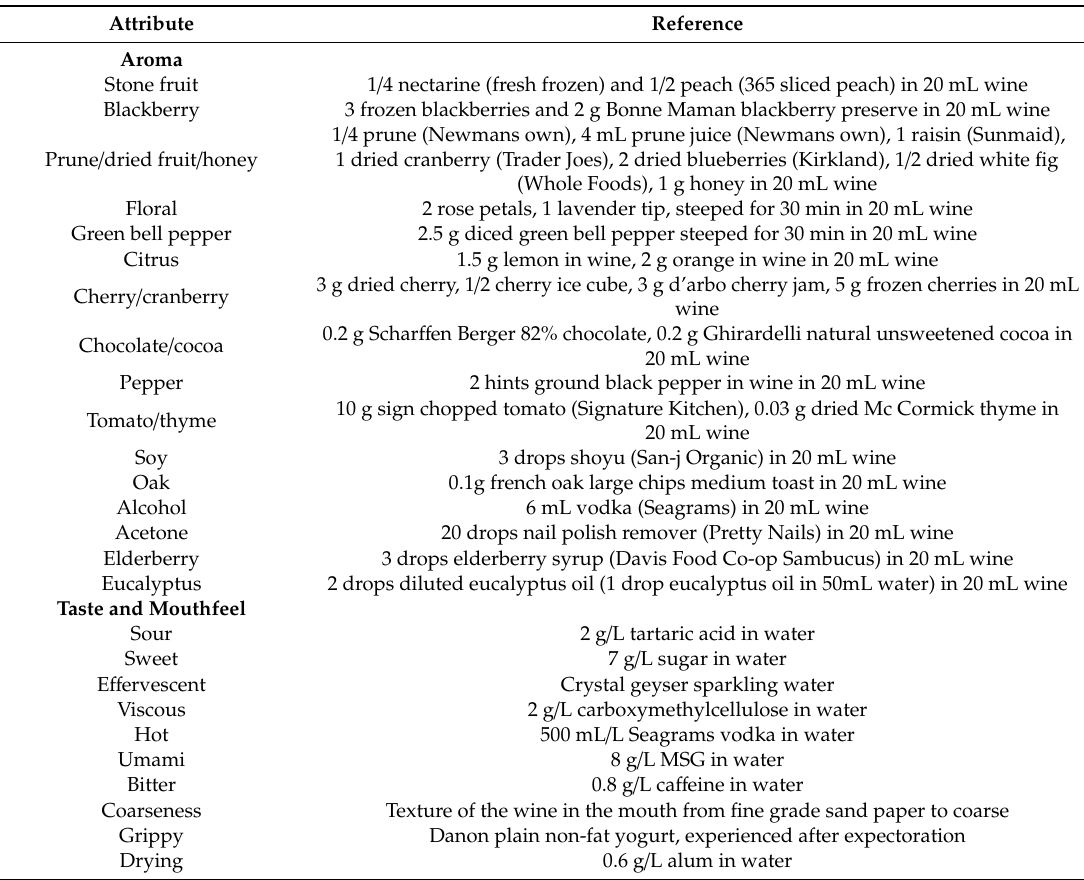
Table 9. Attributes used in the descriptive analysis (DA) and the corresponding reference standards in